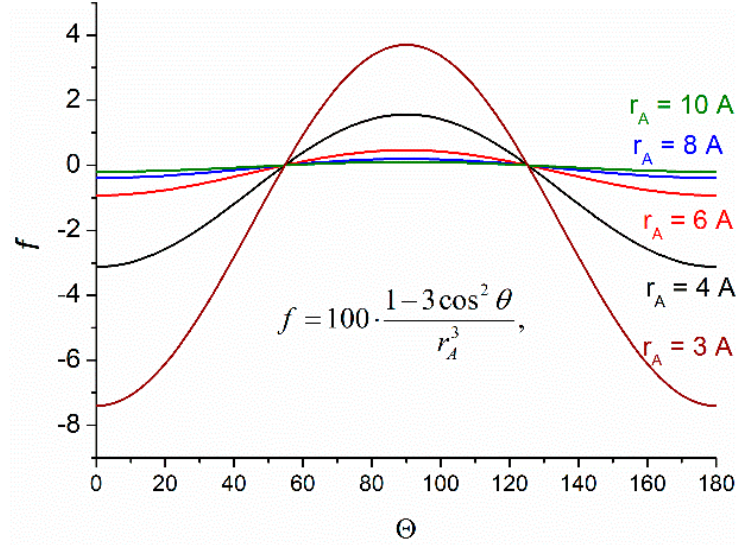
Figure 8. Dependence of the electron dipole–dipole interaction on the angle θ between radius vector connecting the paramagnetic centers and the direction of the external magnetic field.